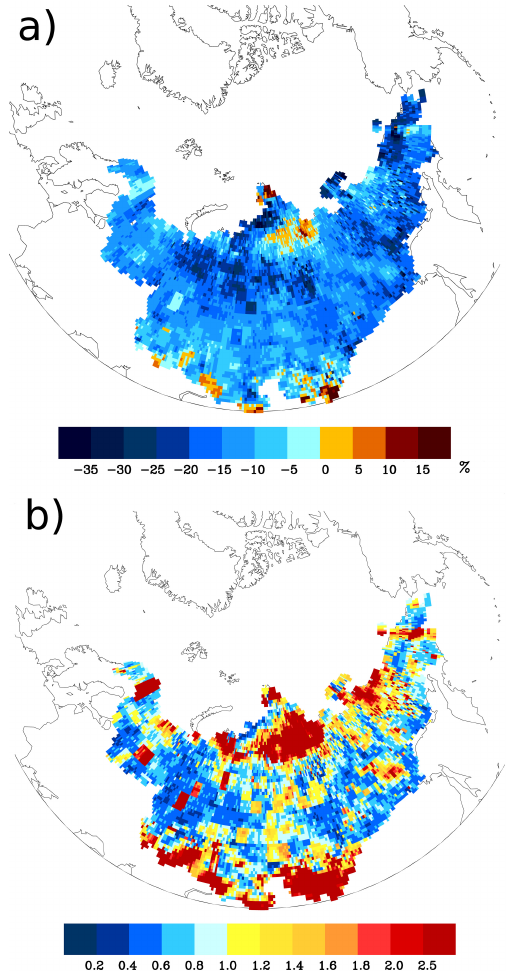
Figure 14. (a) Change in soil organic carbon (SOC) residence time (RT) averaged across all nine models. Change is significant for 46% of the region, predominantly negative changes (decreases). (b) CV for RT as estimated from the across-model mean and standard devi- ation at each